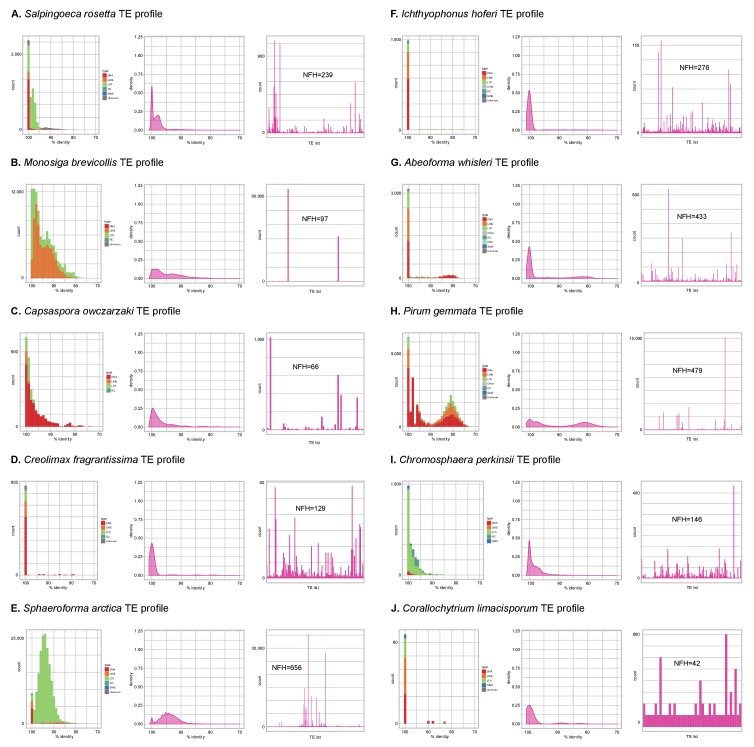
Profile of TE composition of unicellular Holozoa.(A-J) Profile of transposable element (TE) composition of 10 unicellular Holozoa, including (i) distribution of sequence similarity frequencies within the TE complement obtained from BLAST alignments (minimum 70% identity and 80 bp alignment length); (ii) same data but using density-normalized plots; and (iii) raw counts of hits for each TE family, indicating the number of families with hits (NFH) for each species. Each third panel illustrates how TE complements can be biased towards a handful of families with a high number of similarity hits (e.g. Monosiga or Pirum) or, conversely, exhibit even distributions (e.g. Corallochytrium).